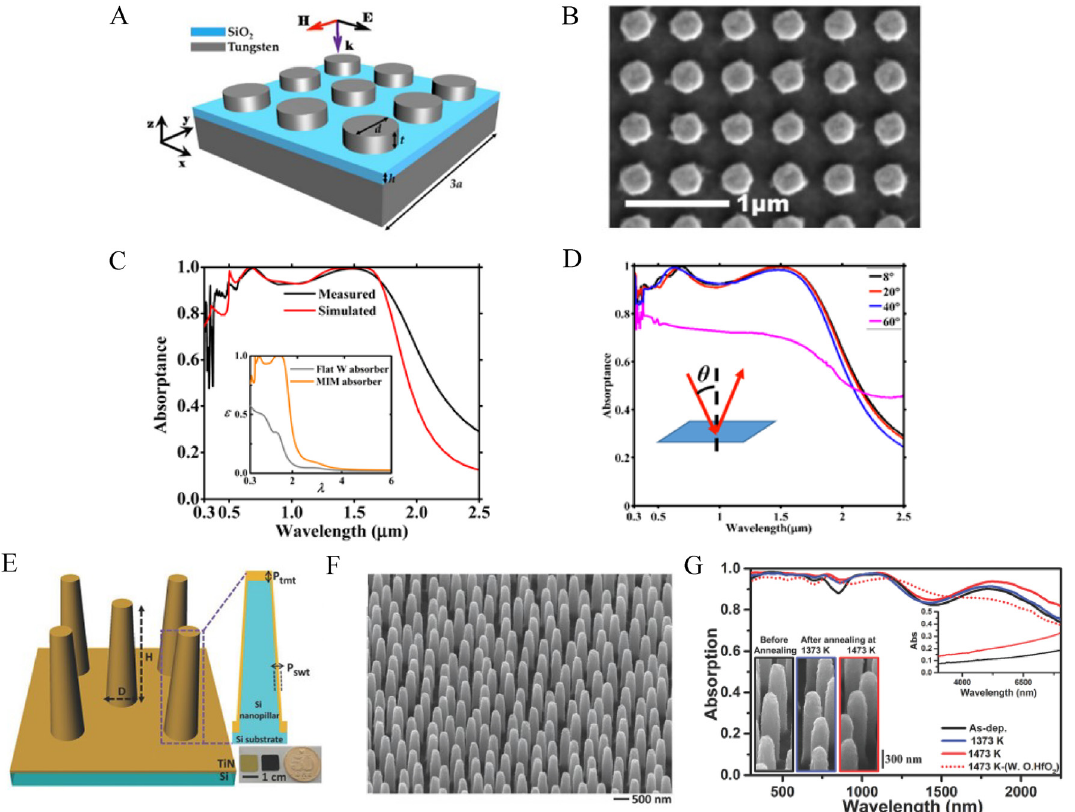
Figure 15: (A) Schematic representation and (B) top-view SEM image of tungsten-based absorber. (C) Simulated and measured absorption spectra of tungsten-based absorber. (D) Measured spectral absorption of tungsten-based absorber under different angles of incidence of 8, 20, 40, and 60 ° [132]. Copyright 2017, Optical Society of America. (E) Schematic and (F) SEM image at 54 ° tilted view of 3D TiN nanopillars absorber.(G)Measuredabsorptionspectraof TiN nanopillarsabsorberbefore andafterannealing at 1473 K [134].Copyright 2017,WILEY-VCH Verlag GmbH & Co. KGaA,